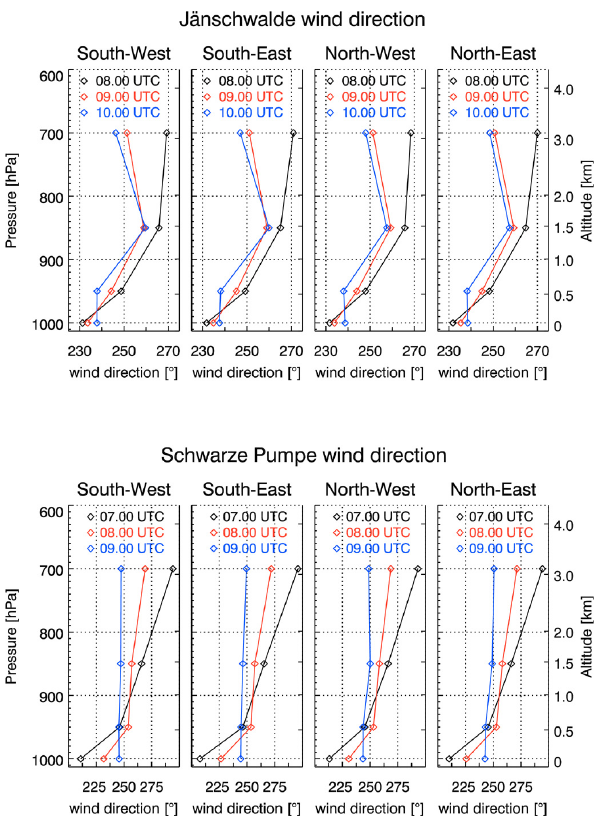
Fig. 5. Figure of wind speeds at the sites of the four nearest neigh- bours of the power plants J¨anschwalde and Schwarze Pumpe ac- cording to the COSMO-DE model as used for the inversion